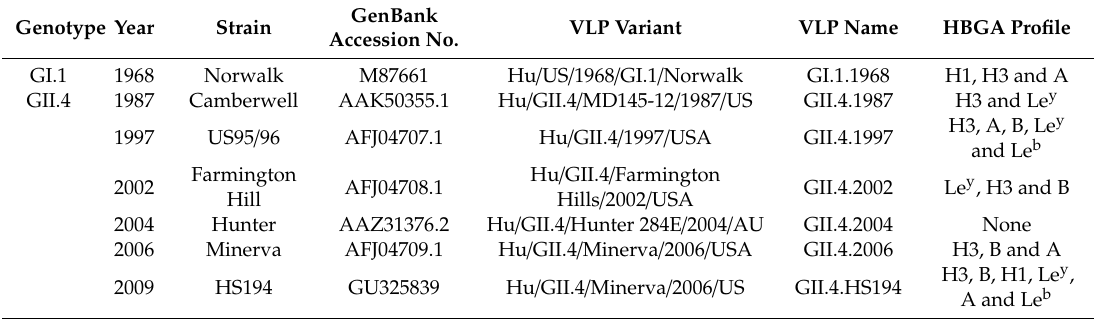
Table 1. A list of virus-like particles of GI.1 and GII.4 used in our study and their histo blood group antigen (HBGA) binding profiles as adapted from previous studies [21,22,24,28,29]. HBGA profile for GII.4.HS194 was generated in this study as described previously